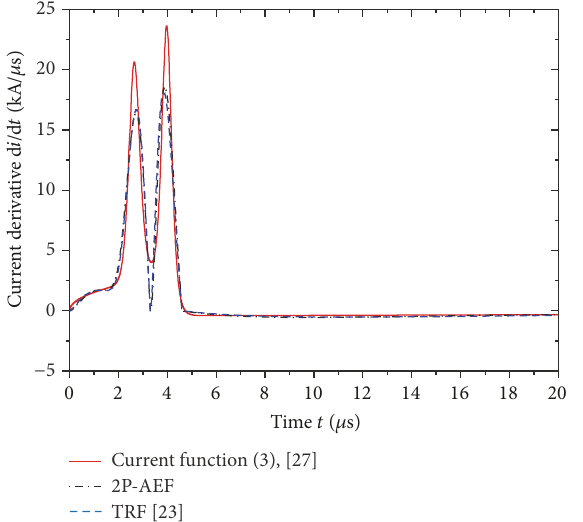
Figure 7: Derivatives of MSS FST#2peaks [20], TRF [23], and 2P- AEF(2,1,2).